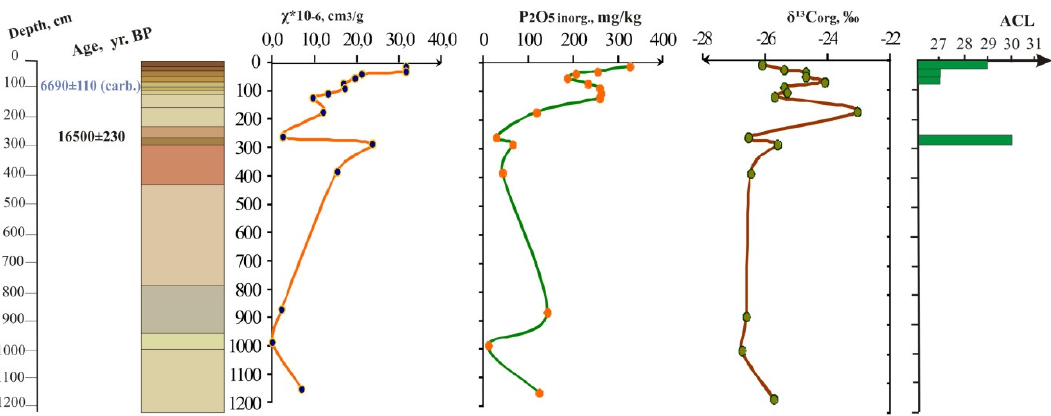
Figure 3. Loess-paleosol sequence with micro-elevation (on the top), Telec quarry, magnetic susceptibility, inorganic phosphorus, stable carbon isotope curves, average chain length in n -alkane distribution.